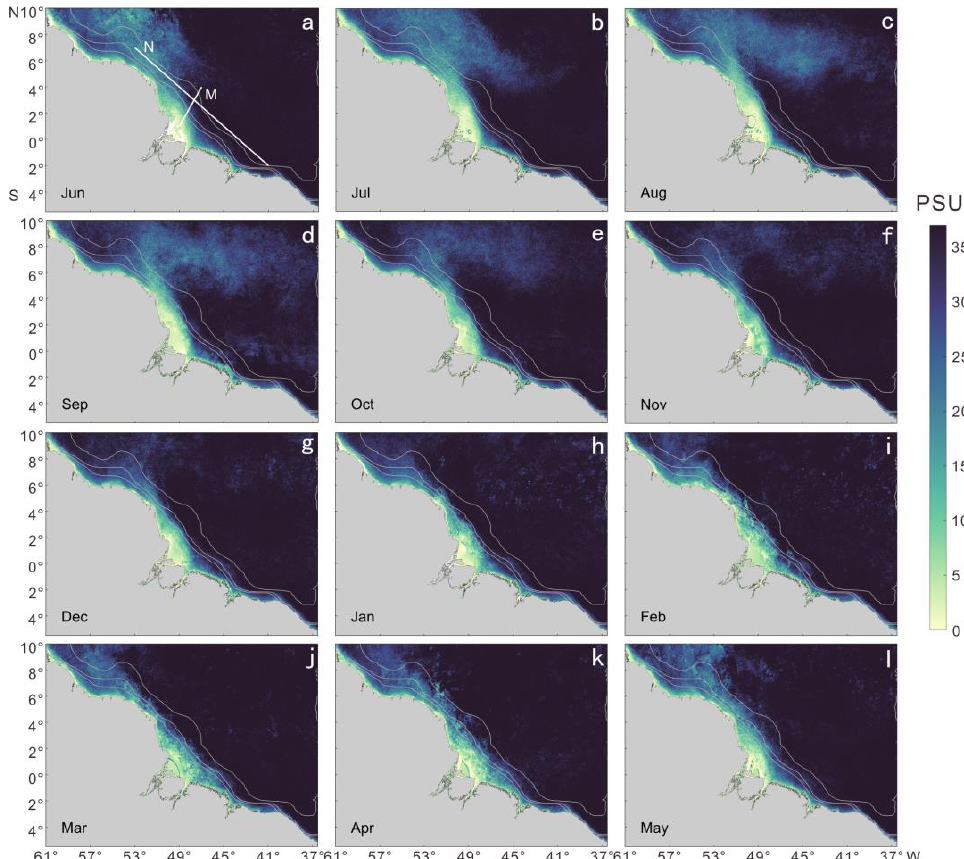
Figure 4. Monthly average SSS over 10 years off the Amazon estuary (2008 – 2017). The grey contour lines from the estuary to the sea are the 50 m, 200 m, and 2000 m isobaths. ( a – l ) correspond to the winter period (June – November) and summer period (December – May) in the southern hemisphere, respectively (unit: PSU). Transects M and N are indicated in ( a ).